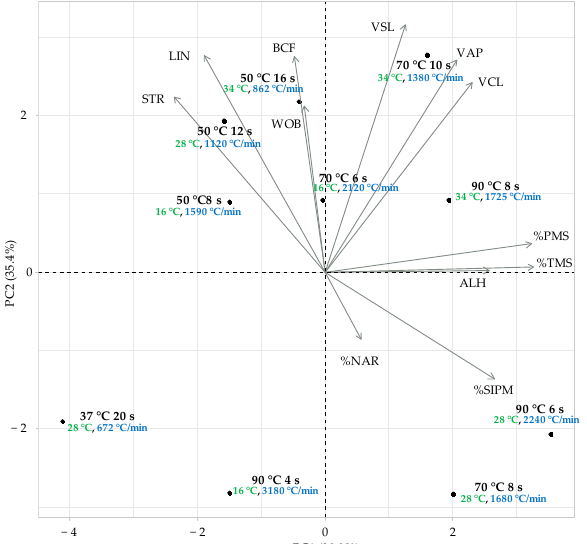
Figure 3. Representation of the first two components of principal component analysis (PCA). %NAR: normal acrosomal ridge, %SIPM: sperm with intact plasma membrane, %TMS: total motile sperm, %PMS: progressive motility sperm, VCL: curvilinear velocity ( μ m/s), VSL: straightline velocity ( μ m/s), VAP: average path velocity ( μ m/s), LIN: linearity (%), STR: straightness (STR, %), ALH: mean amplitude of lateral head displacement (mm), BCF: means of the beat cross frequency (Hz). Green letters indicate the final temperature reached, and blue letters indicate the calculated thawing